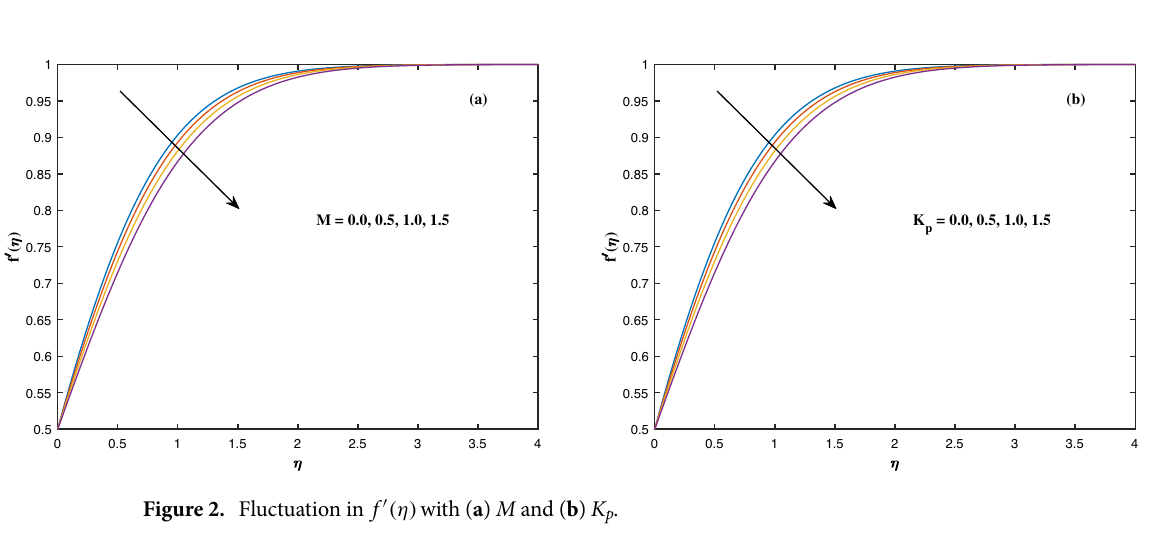
Figure 2. Fluctuation in f ′ (η) with ( a ) M and ( b ) K p